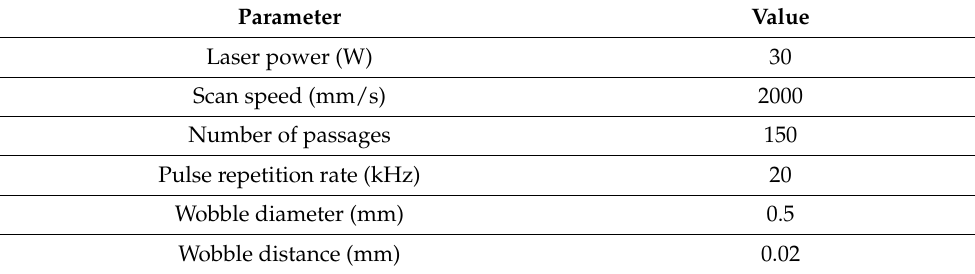
Table 1. Laser parameters used for micro-groove production.